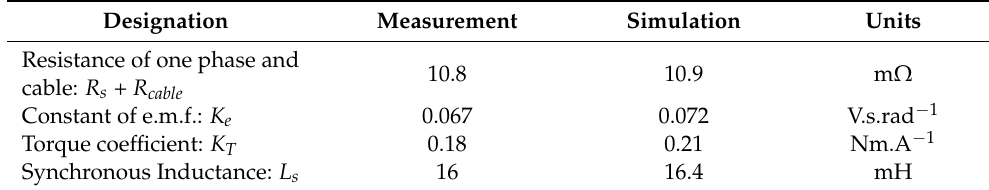
Table 2. Electric parameters.